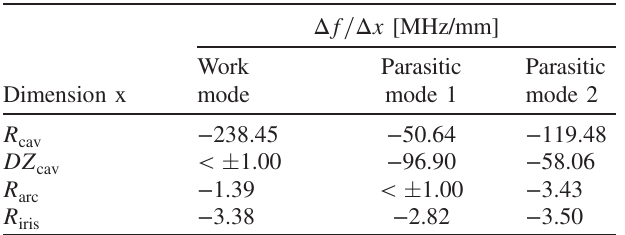
TABLE III. Frequency sensitivity to different geometric param- eters of the working mode and the parasitic modes of the correction cavity.